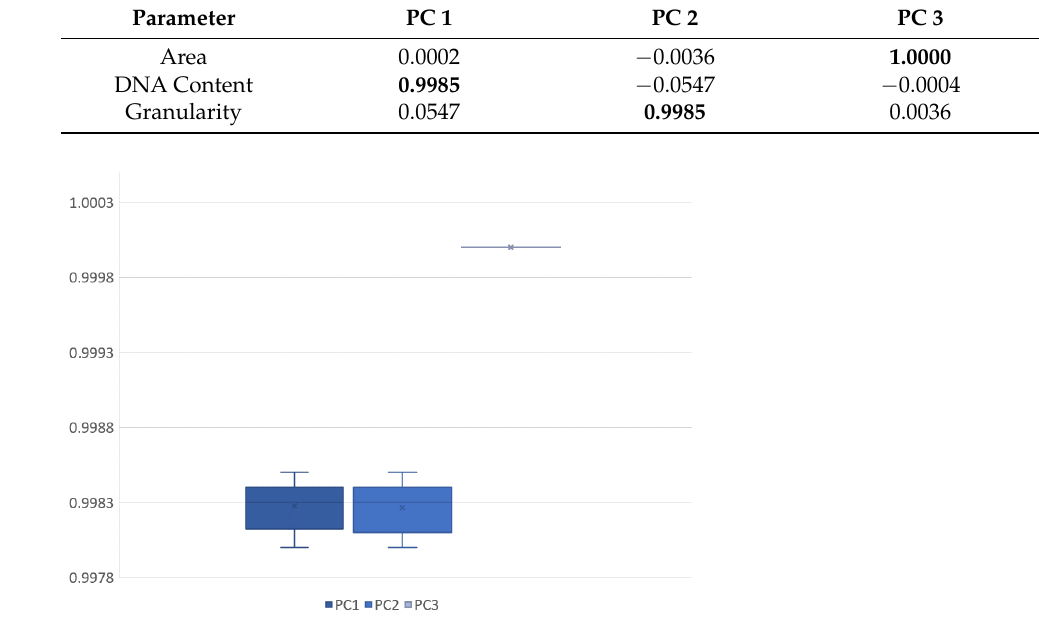
Figure 5. Principal component analysis (PCA) coefficient values across all 17 samples: The three input dimensions are area, granularity, and integrated fluorescence. Such high PCA coefficients mean that there is low dependence between these measured values, and they represent the associ- ated measurements well. PC1 explains DNA content, PC2 explains granularity, and PC3 explains object area.